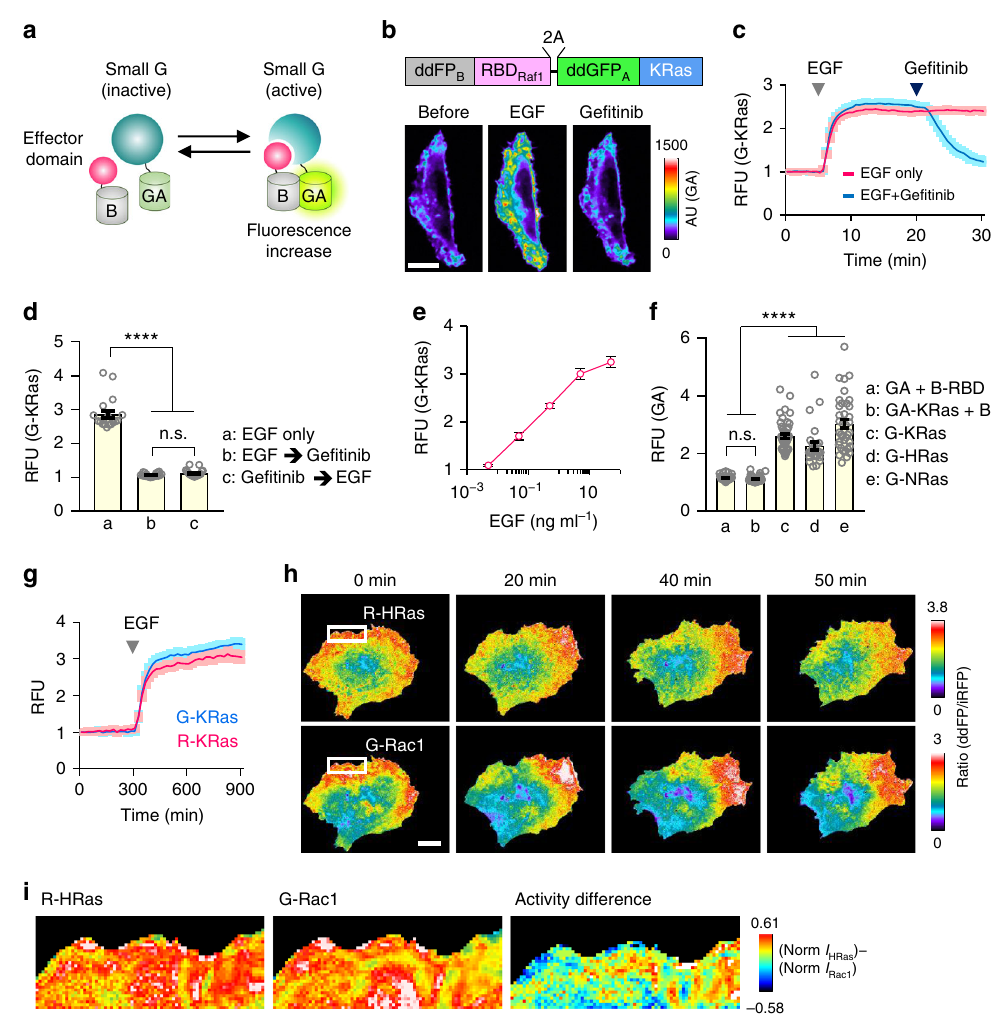
Fig. 1 Development of intensiometric small GTPase biosensors. a Schematic of ddFP-based small GTPase sensor. b (top) Schematic depiction of KRas (G-KRas) sensor construct. (bottom) Fluorescence images showing Ras activity during sequential treatment of EGF (50 ng ml − 1 ) and EGFR inhibitor, ge fi tinib (400 nM). Color bar indicates range of G-KRas intensity. c Time-lapse graph represents reversible fl uorescence change of G-KRas upon EGF or ge fi tinib treatment. n = 77 (blue), 40 (red). d Graph representing maximal fold-changes of GA-KRas intensity in HeLa cells. One way analysis of variance (ANOVA), P < 0.0001 for (EGF vs. ge fi tinib); P < 0.0001 for (EGF vs. pre-ge fi tinib + EGF); P = 0.8948 for (EGF + ge fi tinib vs. pre-ge fi tinib + EGF). n = 19, 20, 19; n.s., not signi fi cant. e Graph showing dose-dependent fold-changes of G-KRas sensor intensity upon EGF treatment. n = 20 for each concentration. f Quanti fi cation of maximal fold change of ddGFP-based Ras GTPase sensors upon EGF treatment. Each group of cells was co-transfected with plasmids as indicated. One way analysis of variance (ANOVA), P < 0.0001 for ( a vs. c , d , e ); P < 0.0001 for ( b vs. c , d , e ); P > 0.9999 for ( a vs. b ). n = 32, 42, 44, 27, 37; n.s., not signi fi cant. g Time-lapse graph showing dynamics of G-KRas and R-KRas sensor intensities upon EGF treatment. Images were captured at 20-s intervals. n = 17 (G-KRas), 18 (R-KRas). h Simultaneous imaging of HRas and Rac1 activities in MDA-MB-231 cell co-expressing R-HRas, G-Rac1, and Lyn- miRFP. Fluorescence ratio images showing Ras and Rac1 activity during cell migration. i (left, middle) Magni fi ed images (area indicated by white boxes in h ) showing subcellular distribution of R-HRas and G-Rac1 activities. (right) A color-coded image showing difference between normalized activities of HRas and Rac1 in subcellular regions. RFU: relative fl uorescence unit; All scale bars, 20 μ m; Error bars, s.e.m. Images or quanti fi ed data are representatives of multiple experiments ( N >